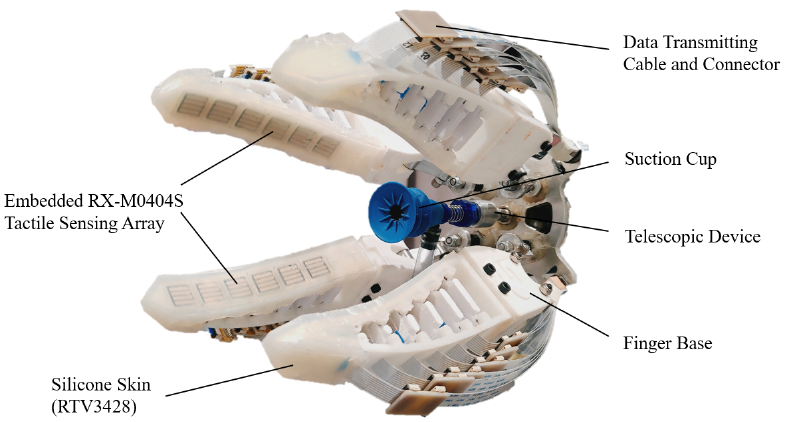
Figure 2. Layout of the tactile sensing